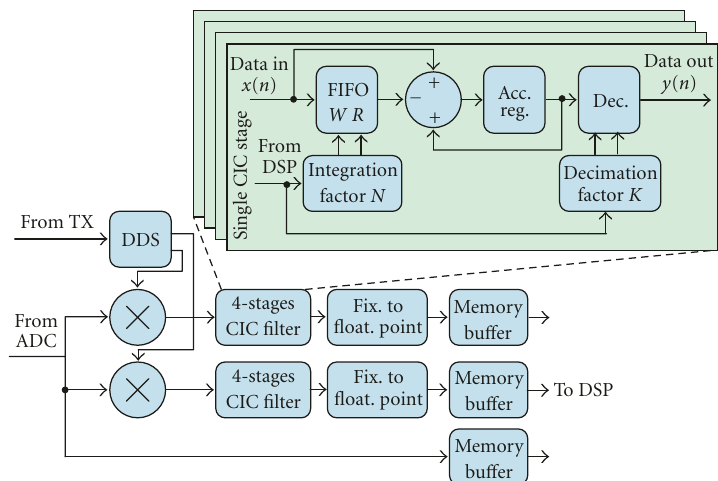
Figure 4: Architecture of coherent demodulators fitted in the FPGA. The zoom box reports details of each CIC filter stage.